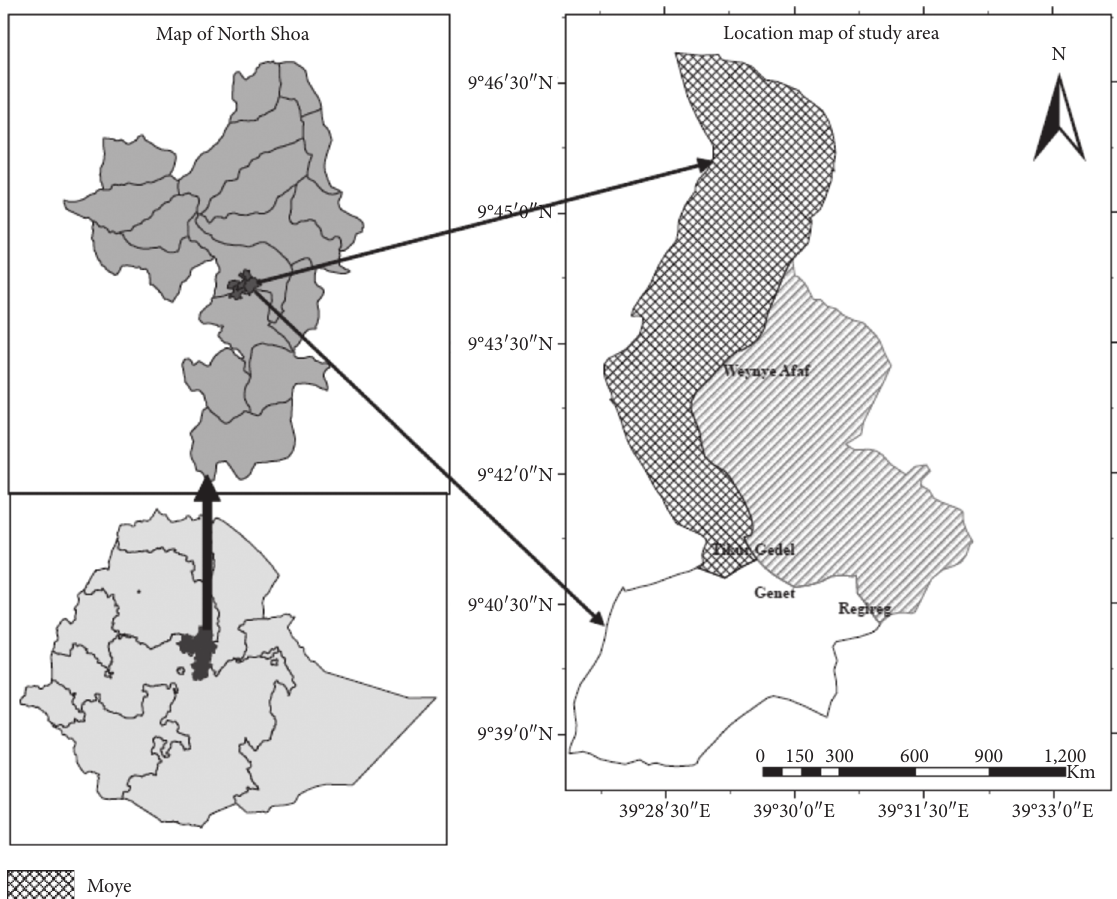
Figure 1: Map of the study